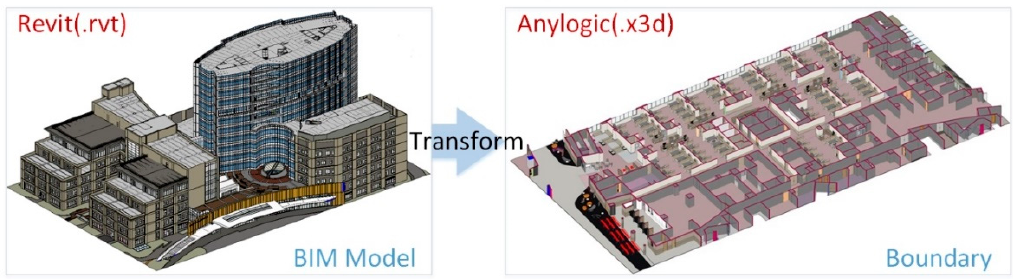
Figure 2. Extracting spatial boundaries from a BIM model for use in the constraint-based simulation.